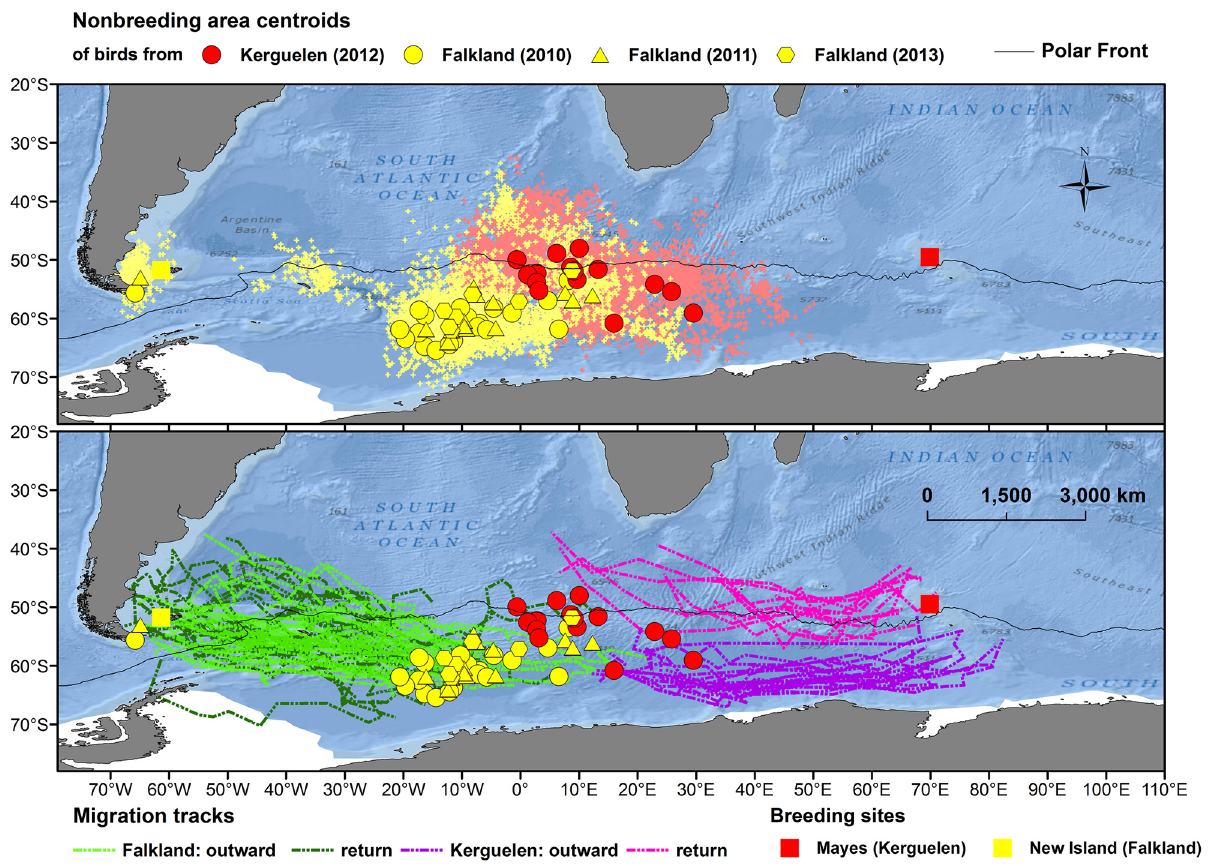
Fig 1. Migration of thin-billed prions from the Falkland and Kerguelen Islands, tracked using geolocators. In the upper map, small dots indicate positions recorded in the non-breeding area, while large symbols show the breeding colonies (squares without black margins) and the centroid positions of 95% kernels for each individual. In the lower map, outward and return journey tacks are